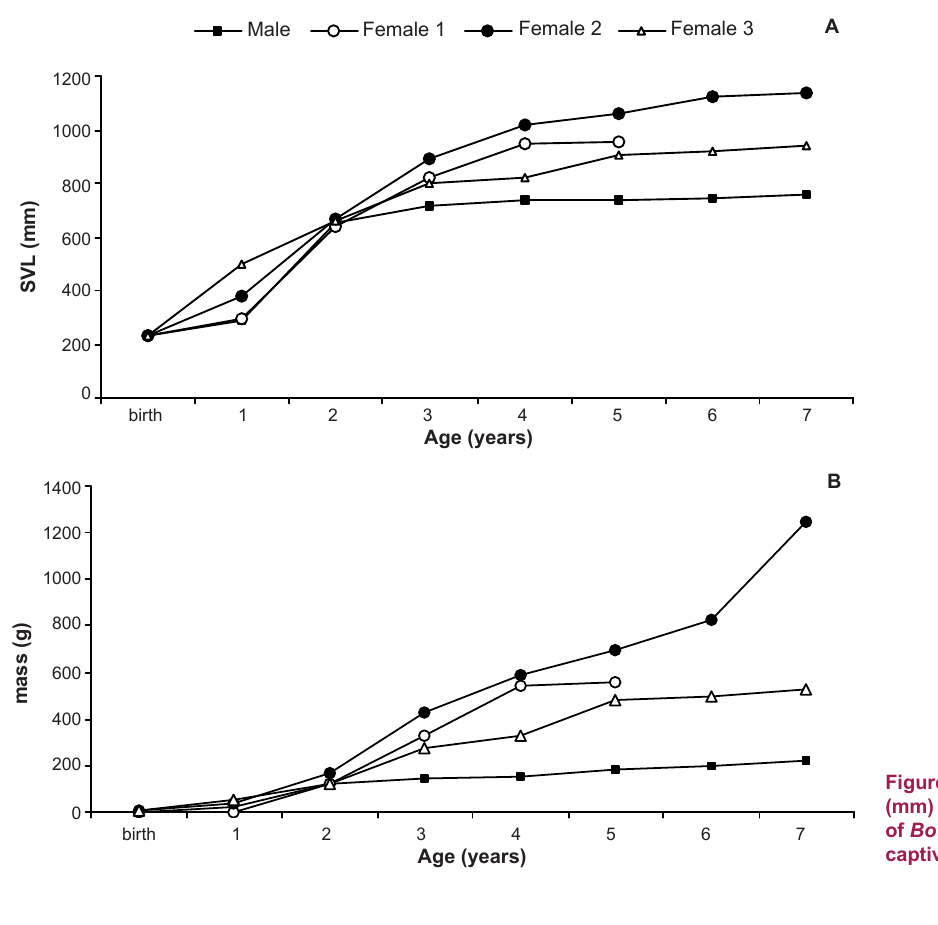
Table 1. Regression analysis of adults Bothrops insularis : biometric data and venom yield.